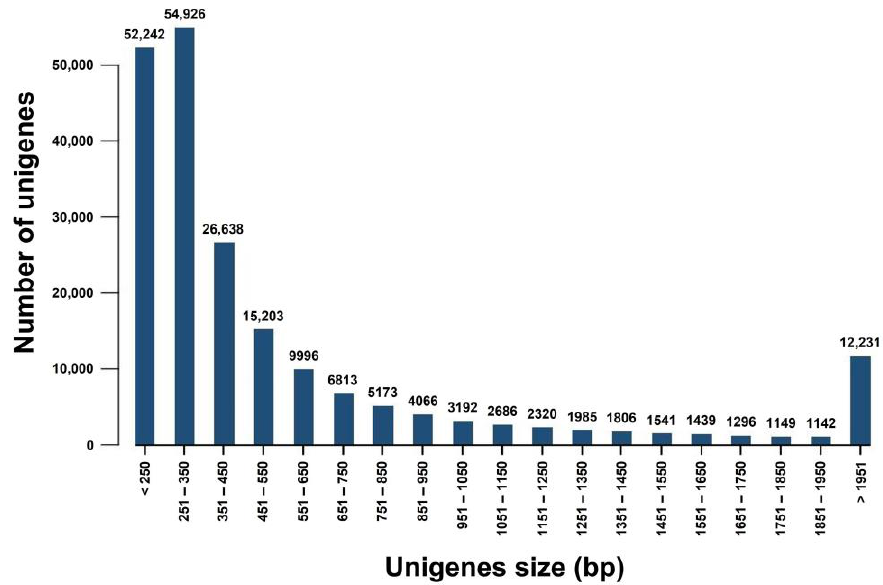
Figure 1. Length distribution of all